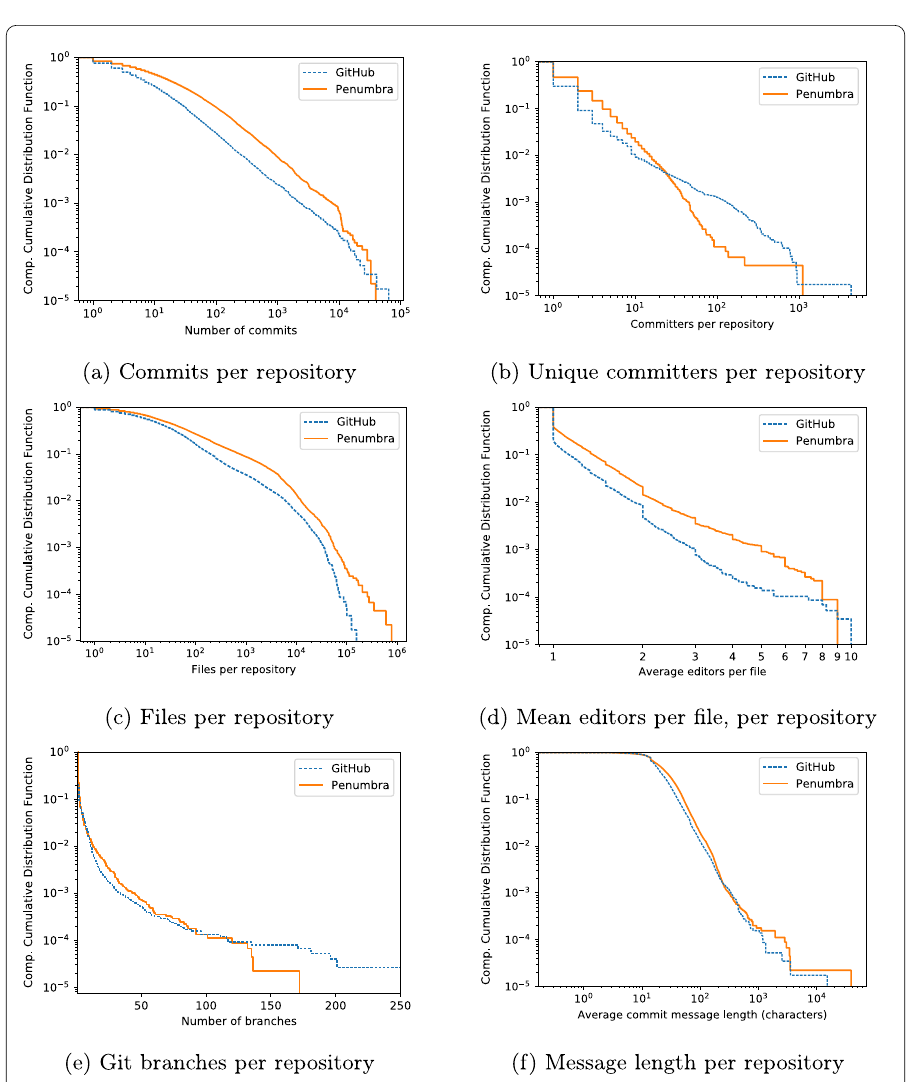
Figure 2 Editing and collaborating in the Penumbra and GitHub. Comparison of GitHub and Penumbra samples on a variety of metrics. Unique users for all plots are determined by unique email addresses in commit data. File counts are taken at the HEAD commit of the main branch. Editor overlap is defined as average number of unique contributors that have edited each file. Panel ( e ) excludes two GitHub